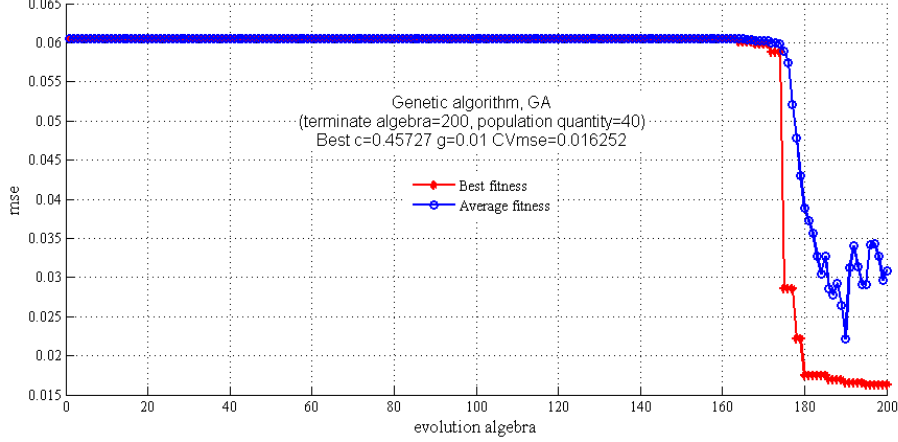
Figure 5. The optimization results for parameters c and g by genetic algorithm.